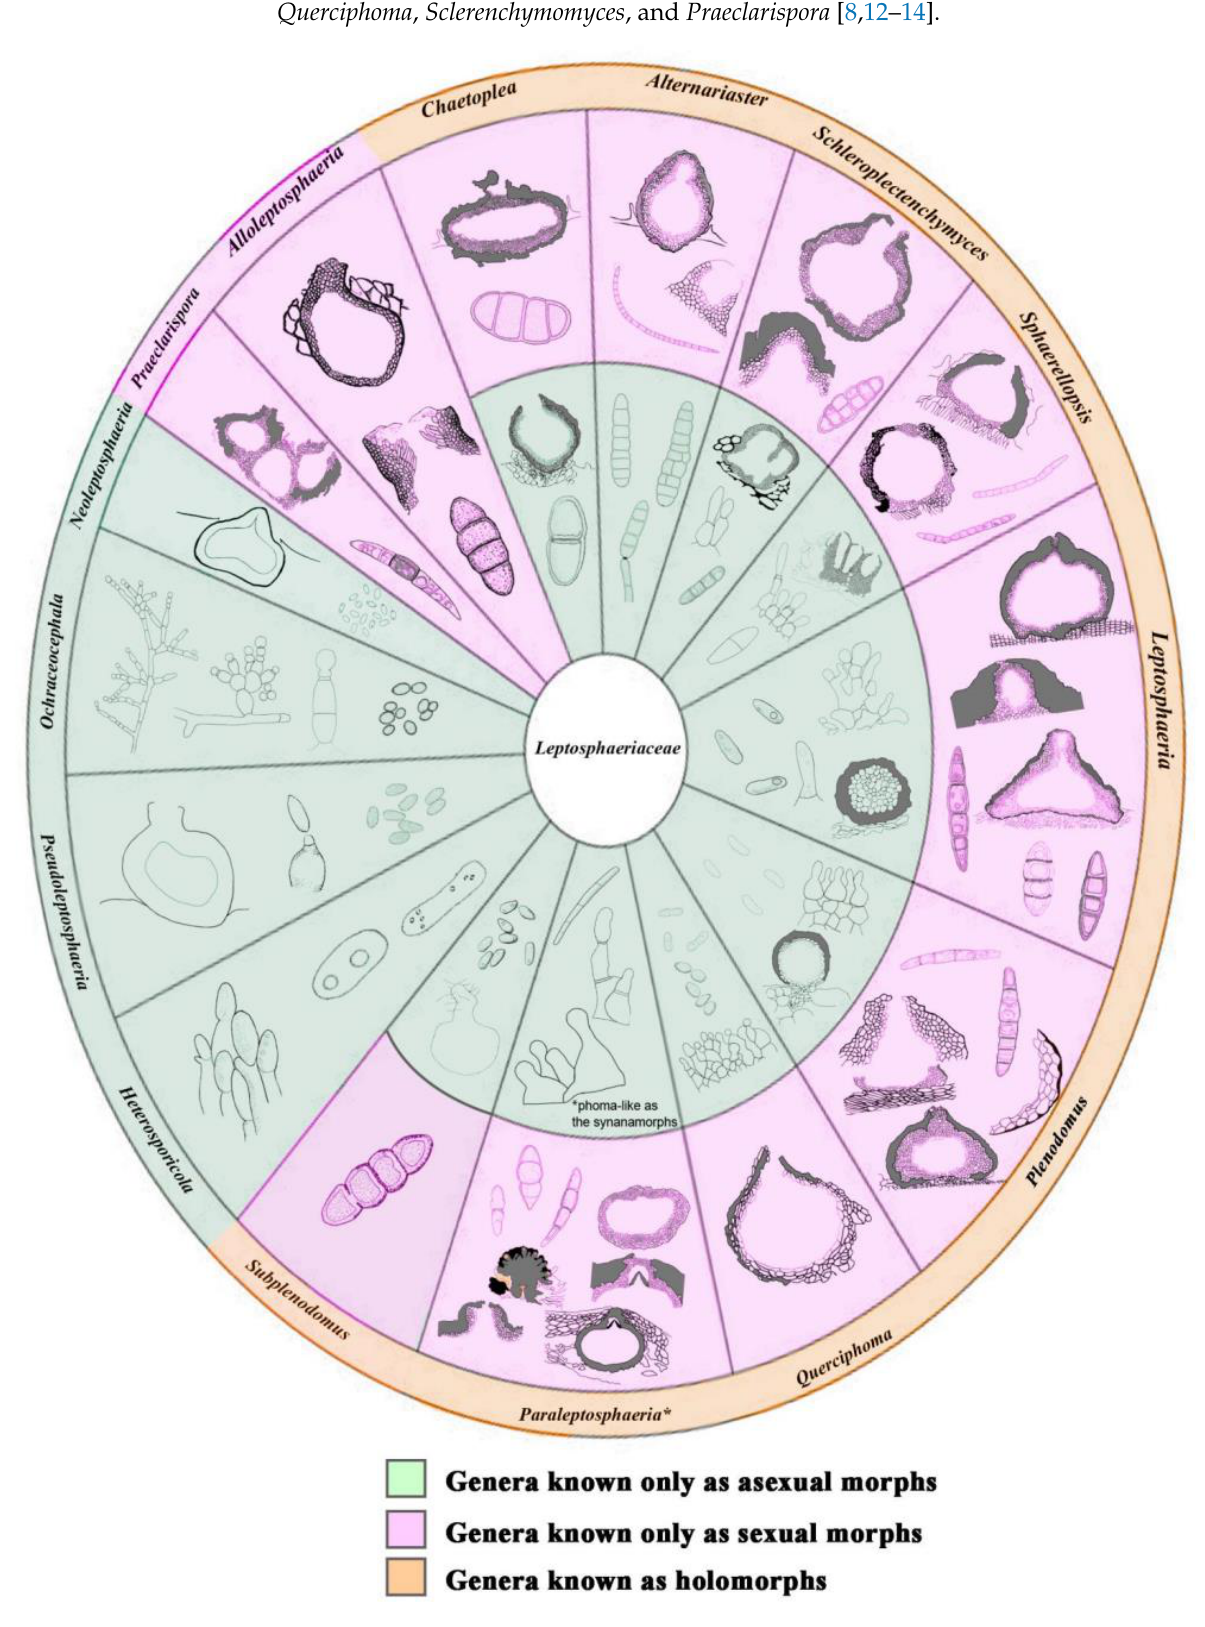
Figure 1. Morphology of ascomata, conidiomata, ascospores, and conidiogenous cells; and conidia of 15 genera in Leptosphaeriaceae . Asterisk (*) indicates the genera with synanamorphs asexual char- acters.